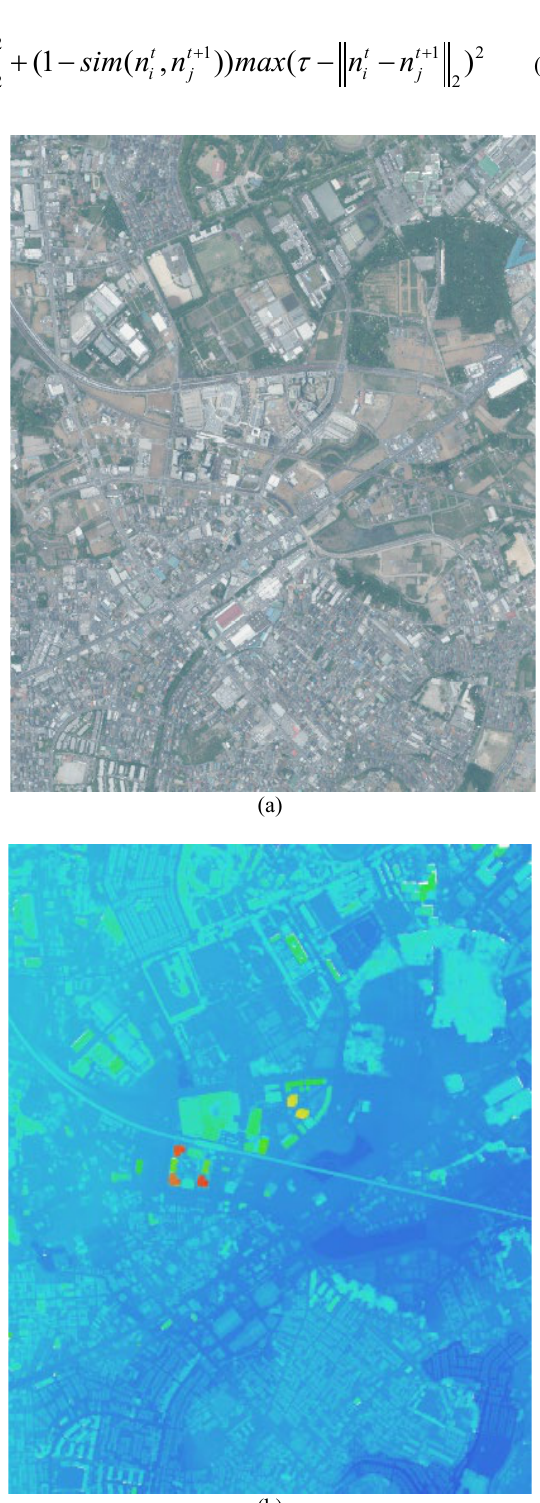
Figure 2. The automatic generated (a) orthophoto and (b) corresponded 3D point